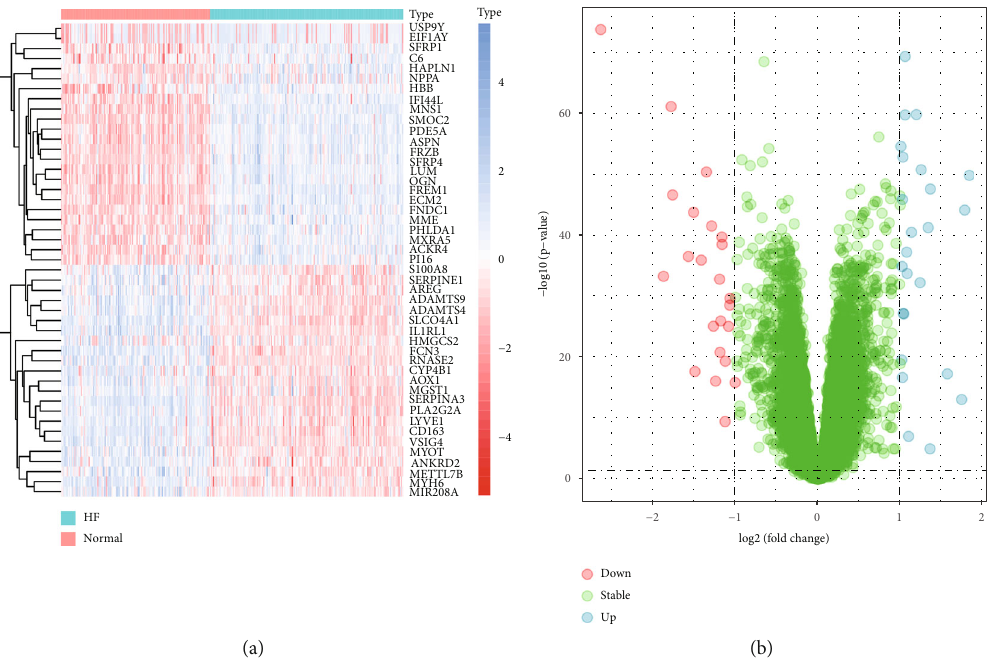
Figure 1: The heat map (a) and volcano map (b) show the di ff erent genes of HF and normal. The blue in the heat map represents the HF sample, and the red represents the normal sample. The red dots in the volcano map indicate downregulated genes, blue dots indicate upregulated genes, and green dots indicate genes with no signi fi cant di ff